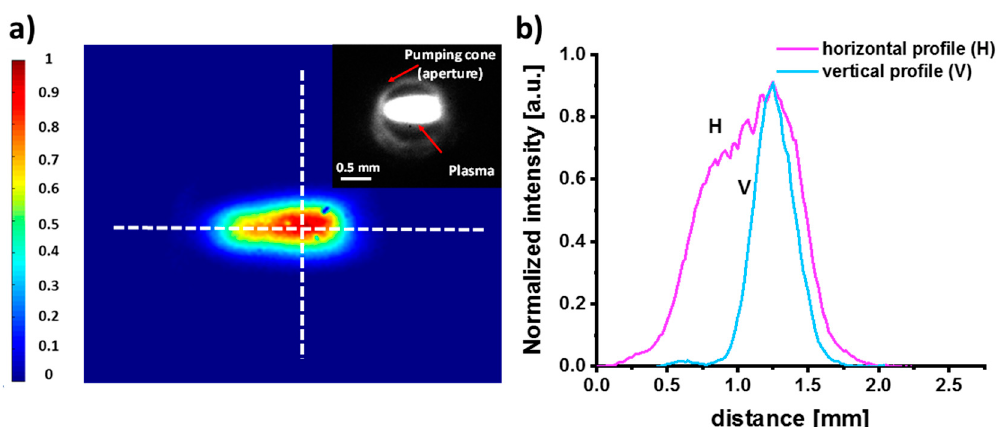
Figure 5. ( a ) Plasma profile in false colors, showing the most intense region of plasma emitting EUV radiation (red). The inset shows the Ar plasma image obtained with a pinhole camera. ( b ) Shows the EUV emission spectrum (H × V) from Ar plasma generated by focusing Nd:YAG laser pulses irradiating a double stream gas-puff target. Figure modified, based on